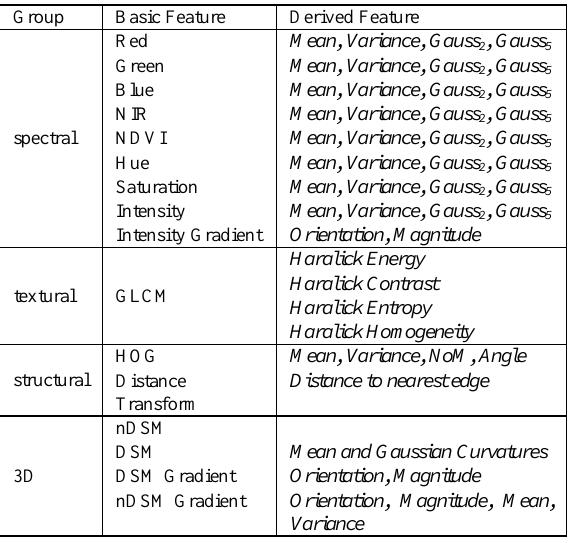
Table 1. Pool of spectral, textural, structural and 3D features extracted per pixel. NIR: Near infrared band of the multispectral DOP. See the main text for the definition of the